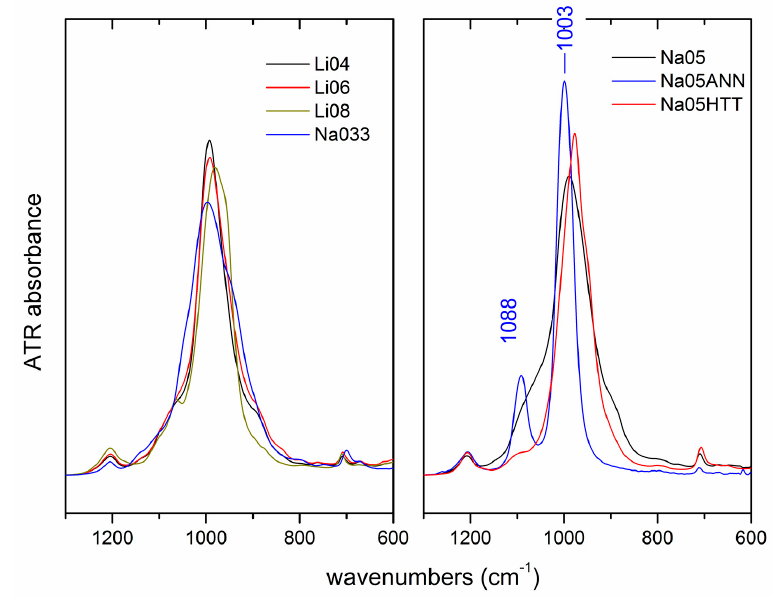
Figure 6. Detail of the ATR spectra of the fluorinated hectorites from third sample set. The spectra were taken from samples fully hydrated with D 2 O and have been subjected to intensity normalization.